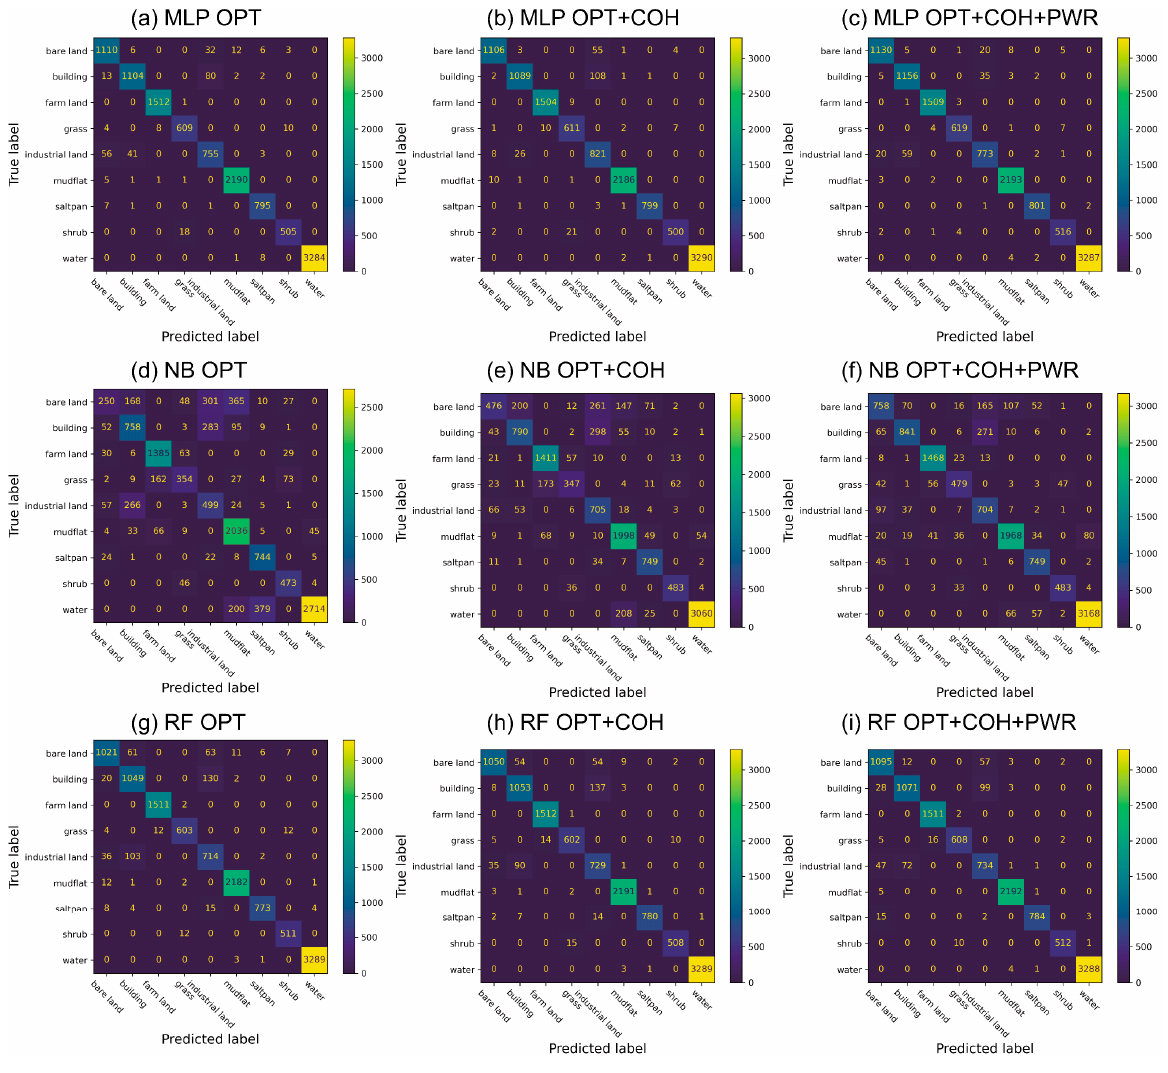
Figure 10. Confusion matrix of three datasets (OPT, OPT + COH, OPT + COH + PWR) classified by supervised classification methods MLP ( a – c ), NB ( d – f ), and RF ( g – i ).